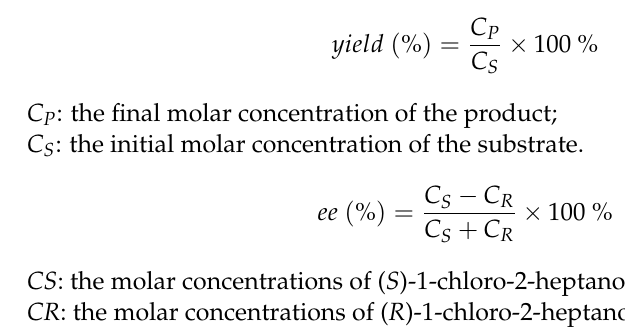
Figure S16: GC graph for bioreduction of octan-2-one to ( S )- octan-2-ol, Figure S17: GC graph Figure S18: GC graph for bioreduction of ethyl 4-chloro-3-oxobutanoate to ethyl ( S )-4-chloro-3- hydroxybutanoate, Figure S19: GC graph for bioreduction of acetophenone to ethyl ( R )-1-phenylethan- 1-ol, Figure S20: GC graph for bioreduction of 1-(3,5-bis(trifluoromethyl)phenyl) ethan-1-one